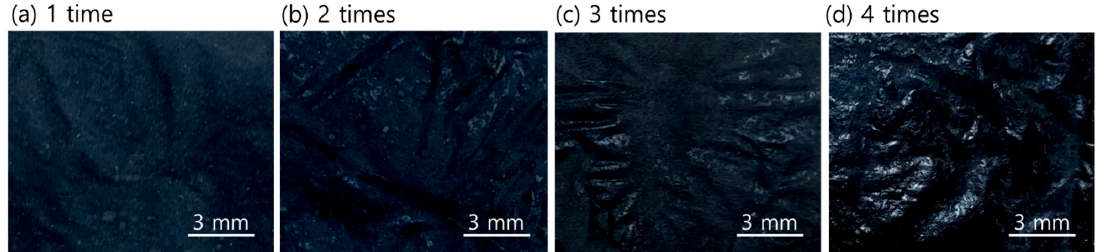
Figure 8. Actual images of the samples treated with PEDOT:PSS one to four times; ( a ) PD1-D, ( b ) PD2-D, ( c ) PD3-D, ( d ) PD4-D. ( d )